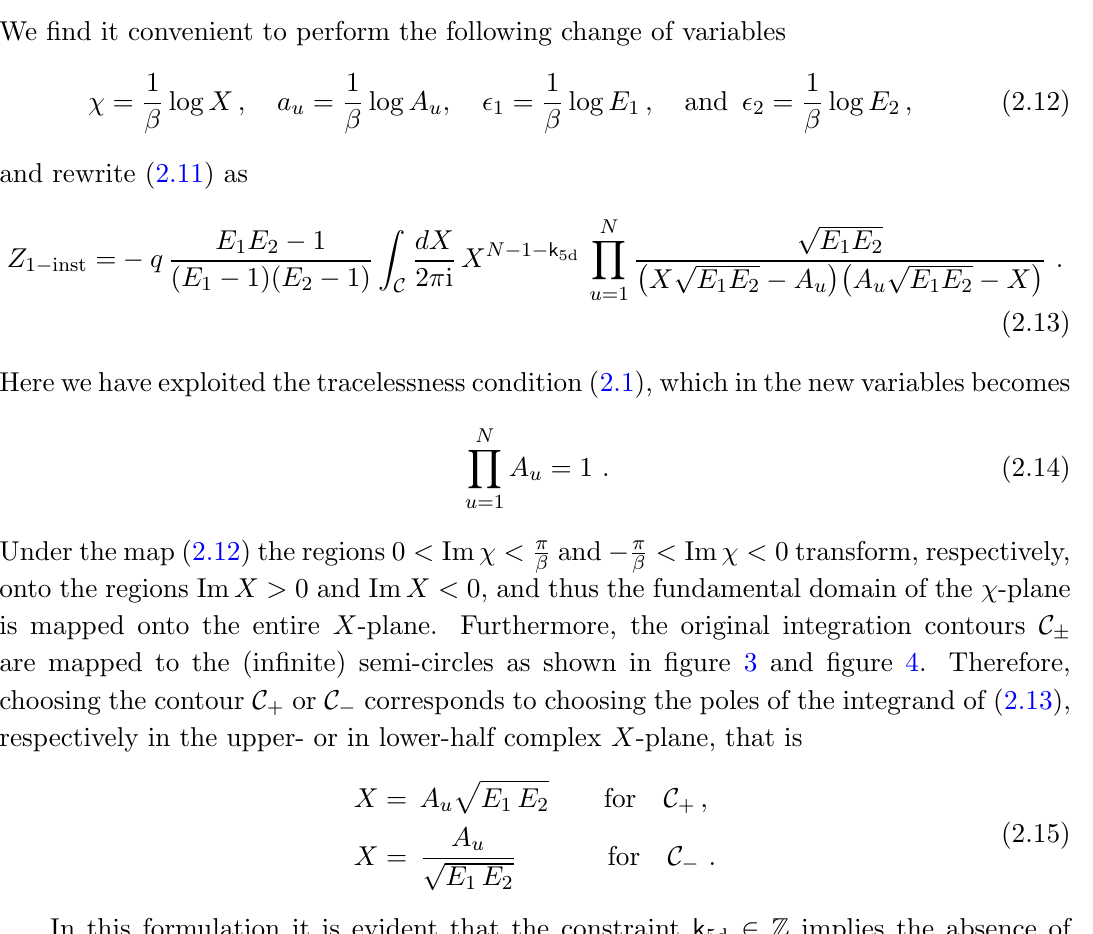
Figure 3 . Map of the contour C + from the (cid:31) -plane to the X